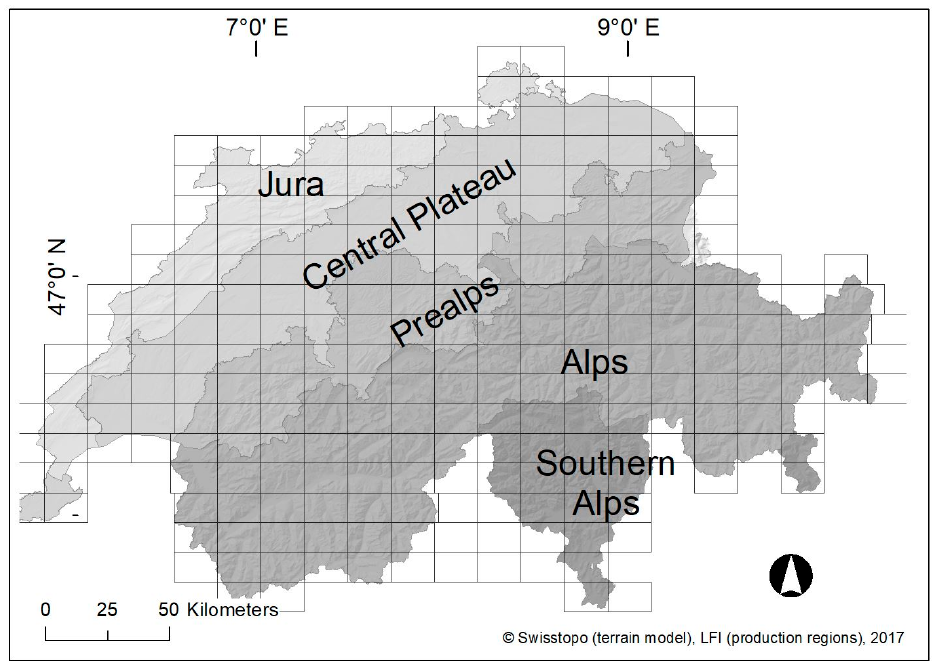
Figure 2. Area of Switzerland with the 220 subsets and the 5 Swiss National Forest Inventory (NFI) forest production regions.